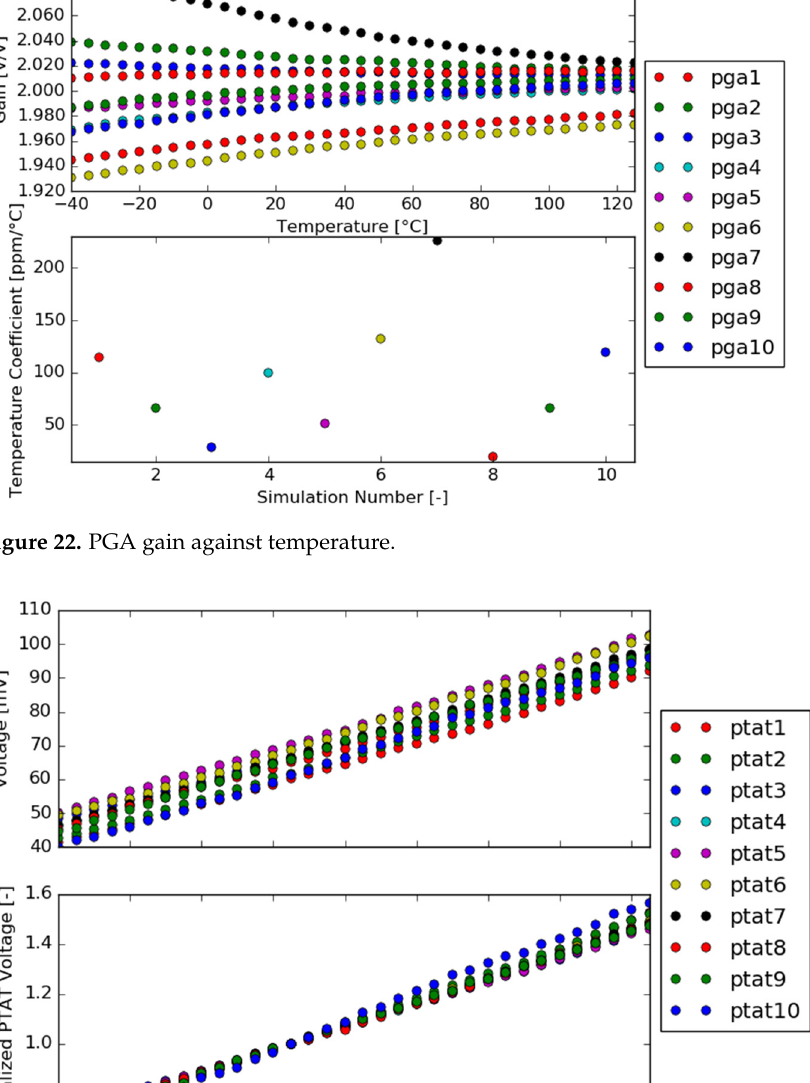
Figure 22. PGA gain against temperature. Table 6. Experimental temperature coefficients of PGA.